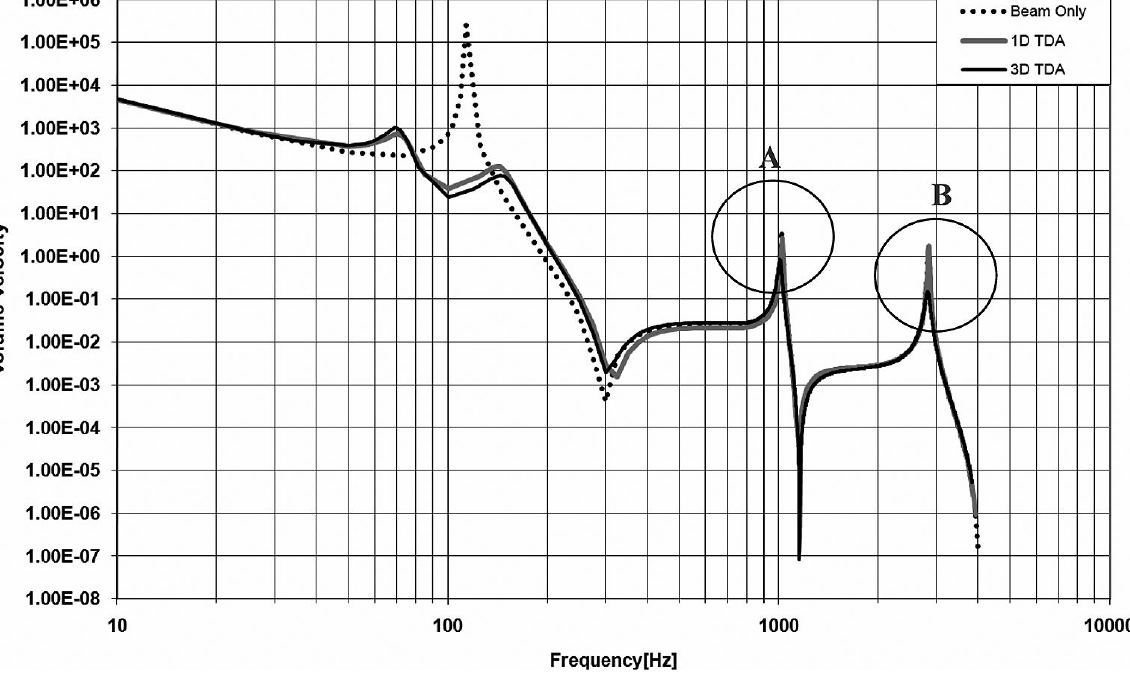
Fig. 12. Frequency response curves for three cases of simply supported beam. Stand alone beam (dotted), beam with added 1D TDA (grey), beam with added 3D TDA